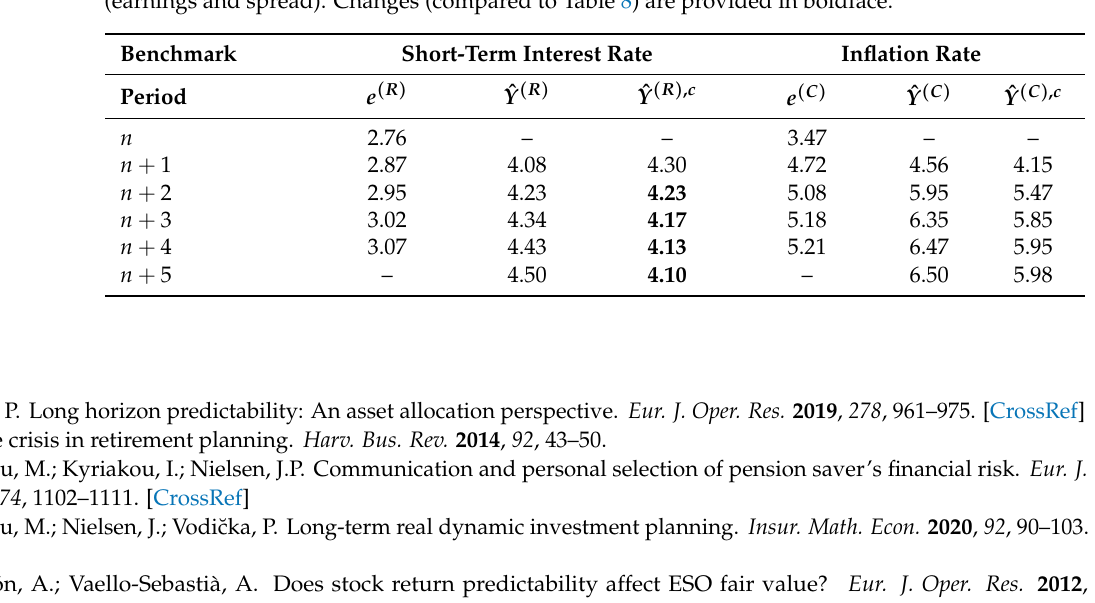
Table A2. Predicted excess stock returns from the econometric model in Section 2.4 under the short- term interest rate benchmark or the inflation rate benchmark based on common predictive variables (earnings and spread). Changes (compared to Table 8) are provided in